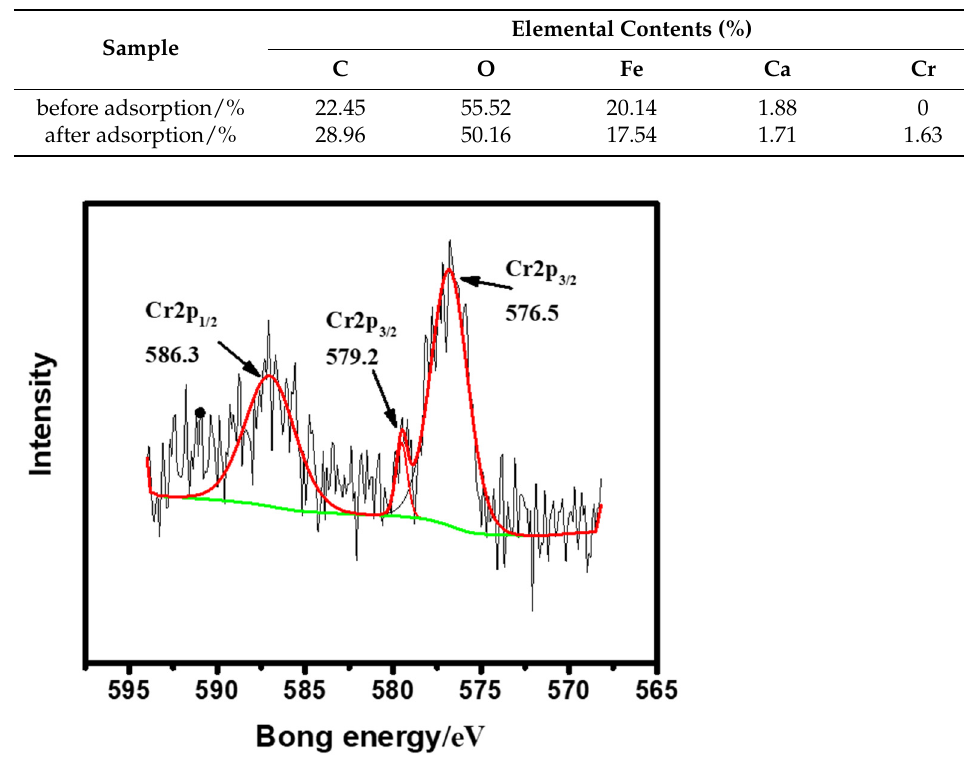
Table 7. Element content of SP@nZVI before and after adsorption.